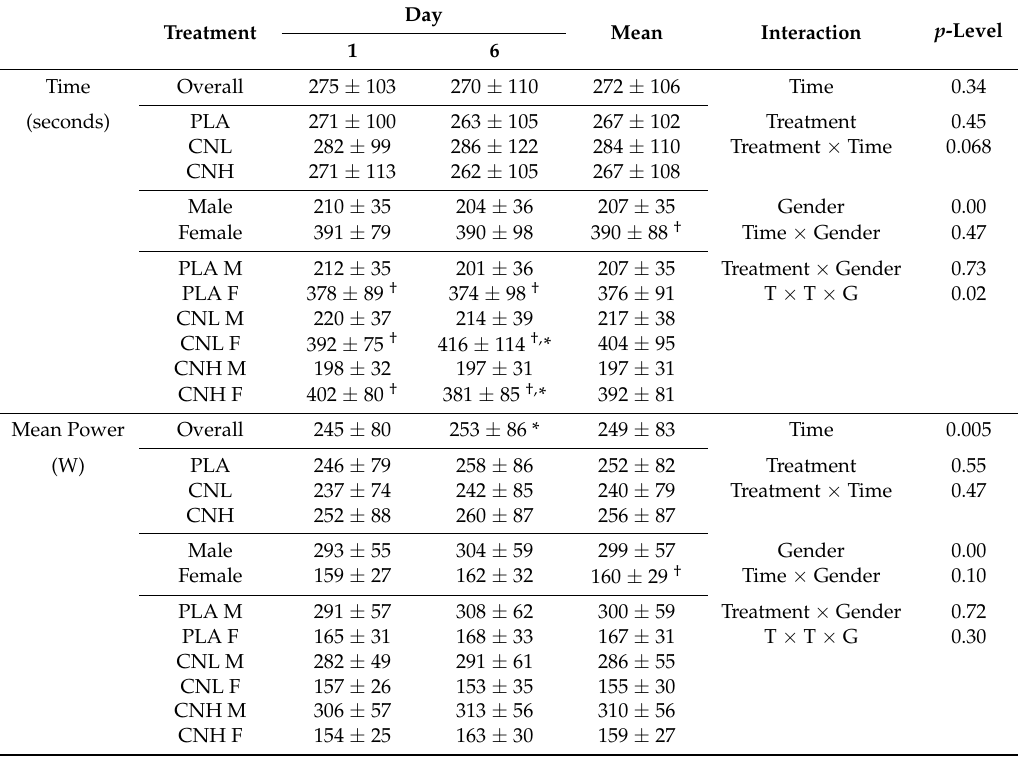
Table 3. Cycling Time Trial Performance.